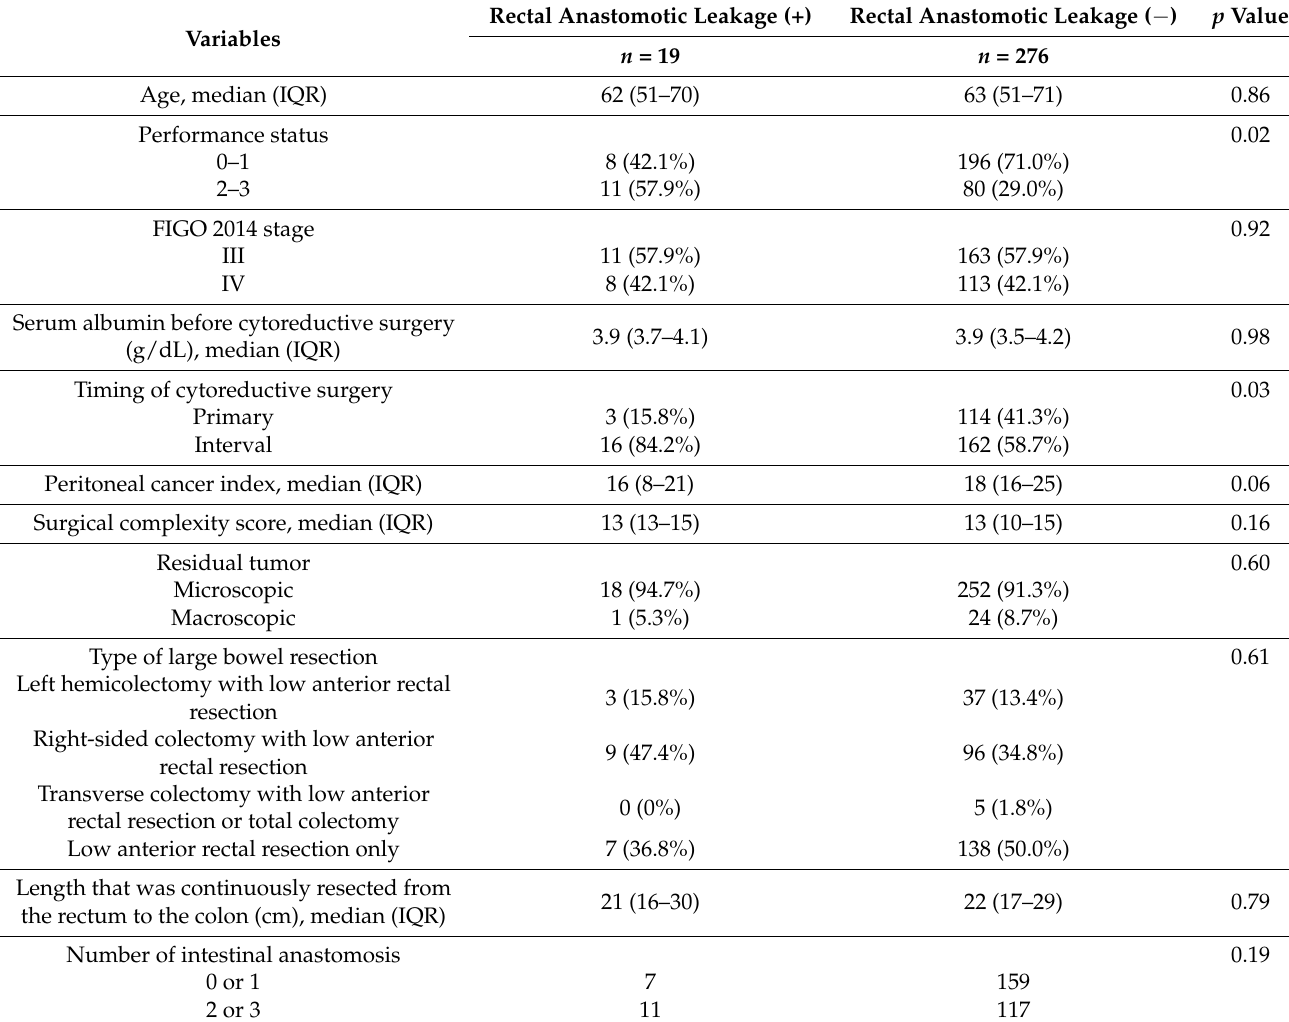
Table 3. Clinical factors for rectal anastomotic leakage.